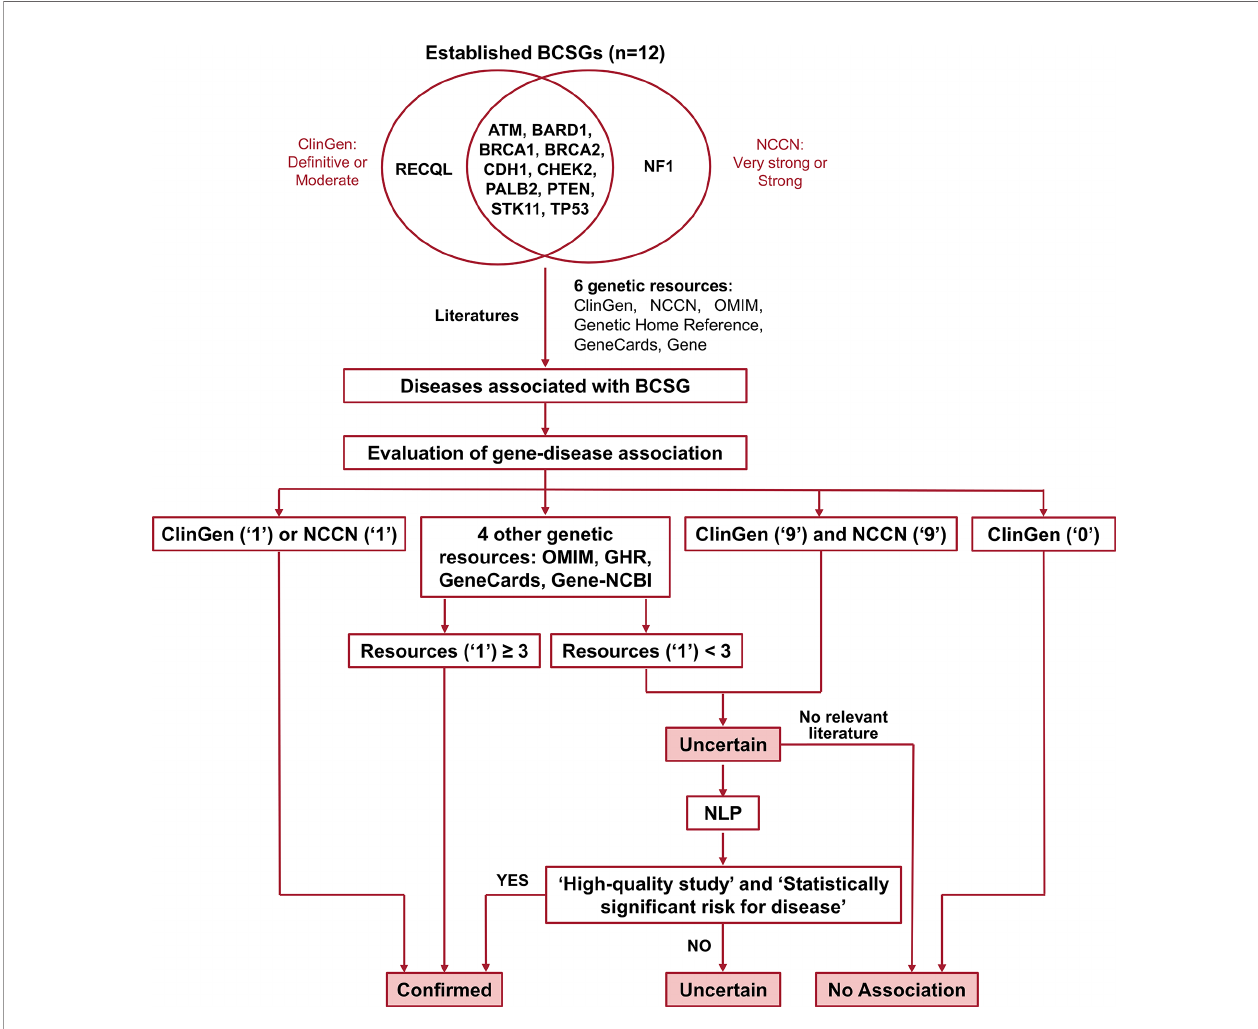
FIGURE 1 | Flow chart for identifying and evaluating gene-disease association. The number ‘ 1 ’ indicates that the gene was associated with BCSG in the resource. The number ‘ 0 ’ indicates that the gene ’ s association with BCSG was refuted in the resource. The number ‘ 9 ’ indicates that the gene ’ s association with BCSG was unclear in the resource. Uncertain association indicates that the gene ’ s association with BCSG is unclear, and further studies are required to refute or accept the association. BCSGs, breast cancer susceptibility genes; NLP, natural language